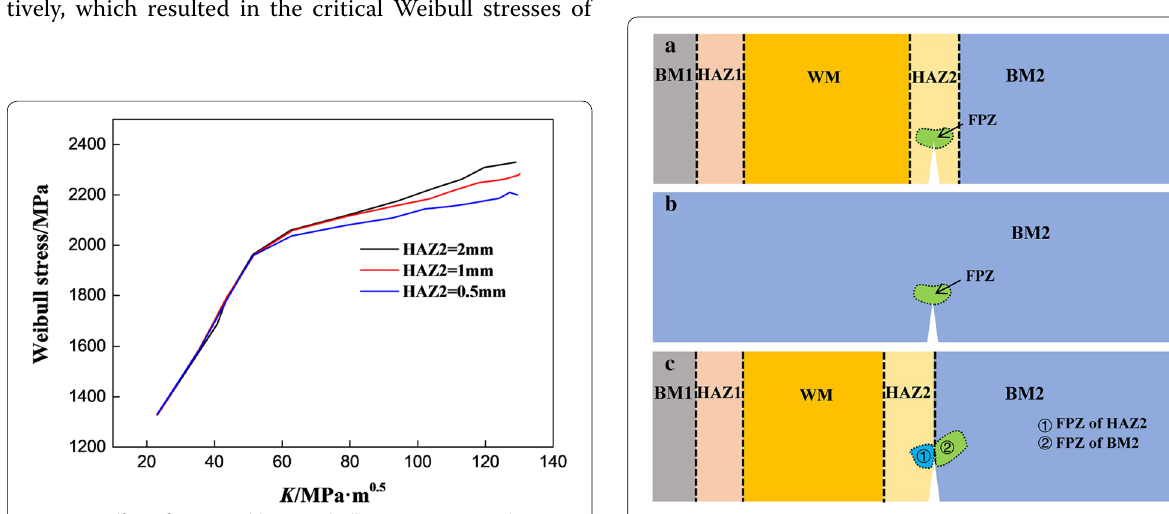
Figure 11 Crack location in SENB specimen: a Crack in HAZ2; b Crack in BM2; c Crack at BM2/HAZ2